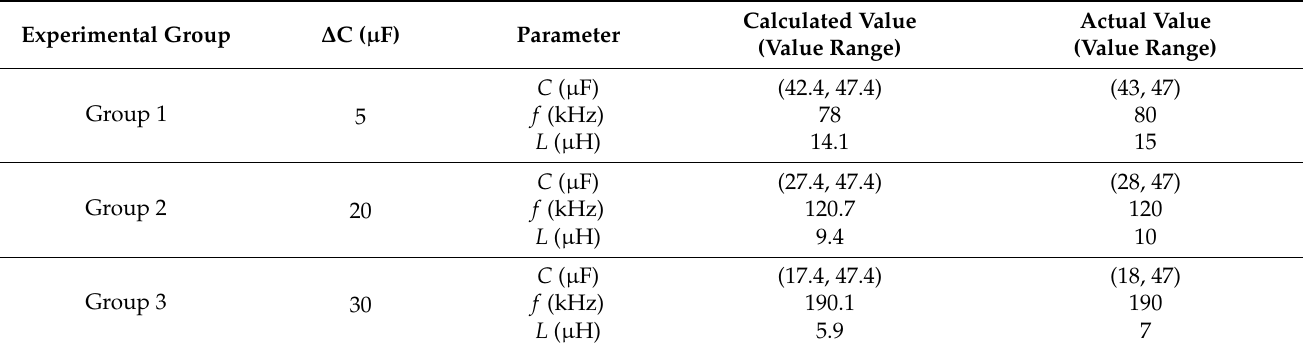
Table 1. Calculated and actual values of the prototype.